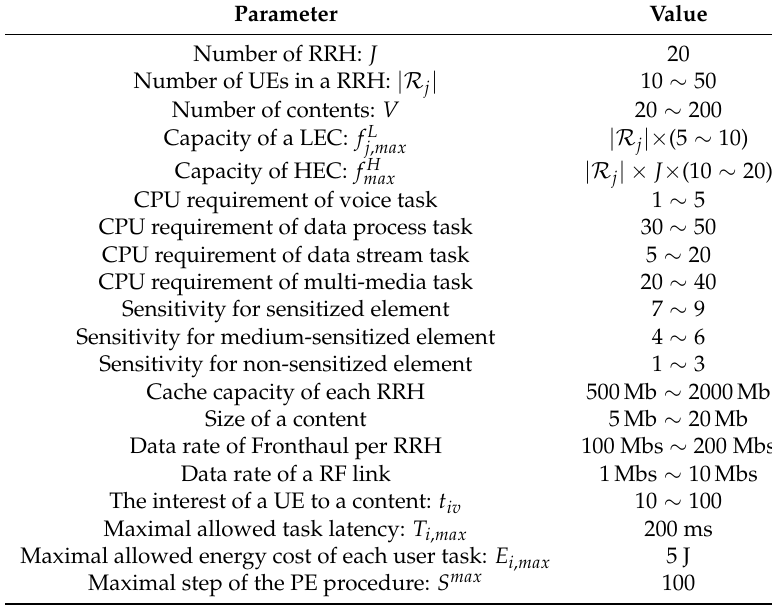
Table 2. Parameters of the